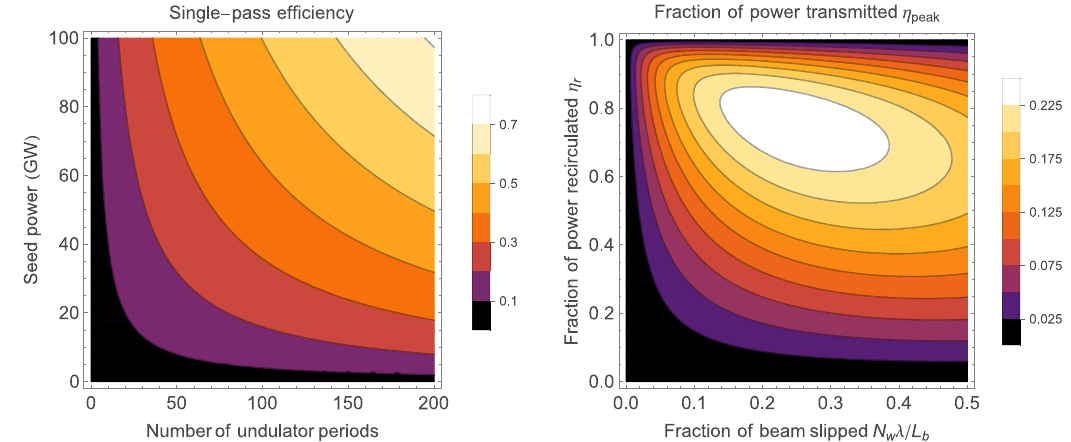
FIG. 3. Left: Single pass TESSA power extraction efficiency η e for a 250 MeV beam, K 0 ¼ 4 as a function of input power and number of undulator periods. Right: Oscillator efficiency as a function of number of periods and output coupler reflectivity.